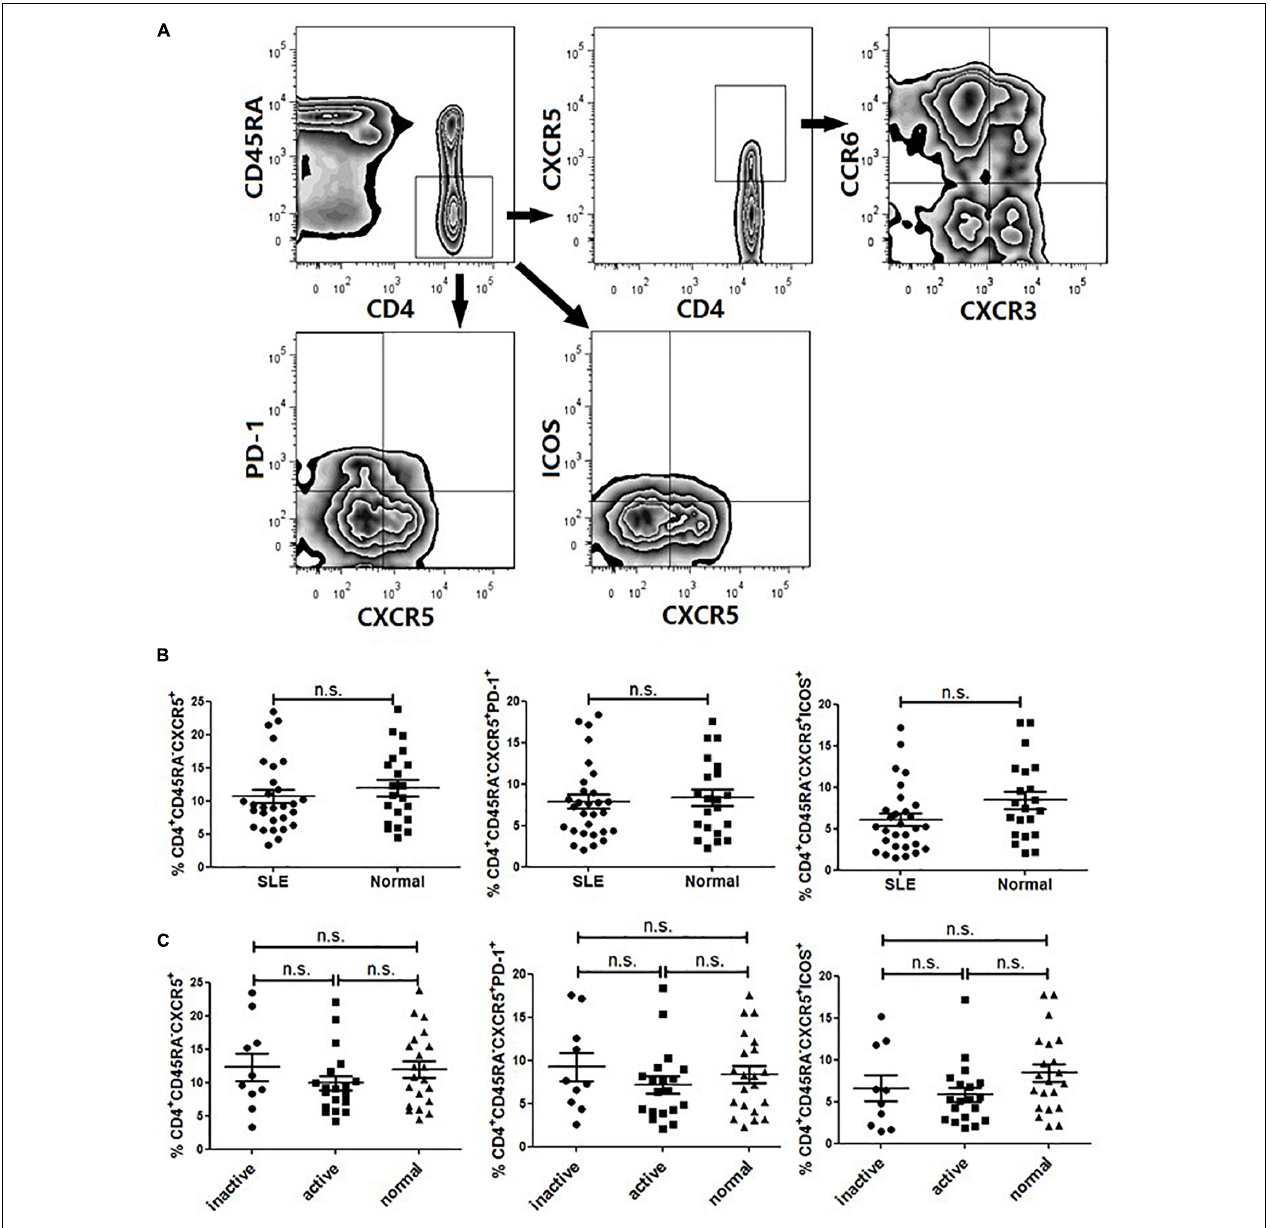
FIGURE 1 | FACS analysis and circulating Tfh cells in SLE patients. PBMCs were isolated and stained with labeled antibodies specific for CD4, CD45RA, CXCR5, ICOS, PD-1, CCR6, CXCR3. (A) Circulating Tfh cells were gated in CD4 + CD45RA - CXCR5 + , CD4 + CD45RA - PD-1 + and CD4+CD45RA-ICOS+ respectively. Then Tfh subsets were determined by CXCR3 and CCR6 expression on gated CD4 + CD45RA - CXCR5 + T cells, allowing the identification of Tfh1 (CXCR3 + CCR6 - ), Tfh2 (CXCR3 - CCR6 - ) and Tfh17 (CXCR3 - CCR6 - ) subsets. (B) Frequencies of CD4 + CD45RA - CXCR5 + , CD4 + CD45RA - PD-1 + and CD4 + CD45RA - ICOS + cell subsets were compared between SLE patients and healthy controls. (C) Frequencies of CD4 + CD45RA - CXCR5 + , CD4 + CD45RA - PD-1 + and CD4 + CD45RA - ICOS + cell subsets were compared between inactive SLE patients, active SLE patients and healthy controls. All results are presented as mean ± standard error of the mean (SEM). ns: not